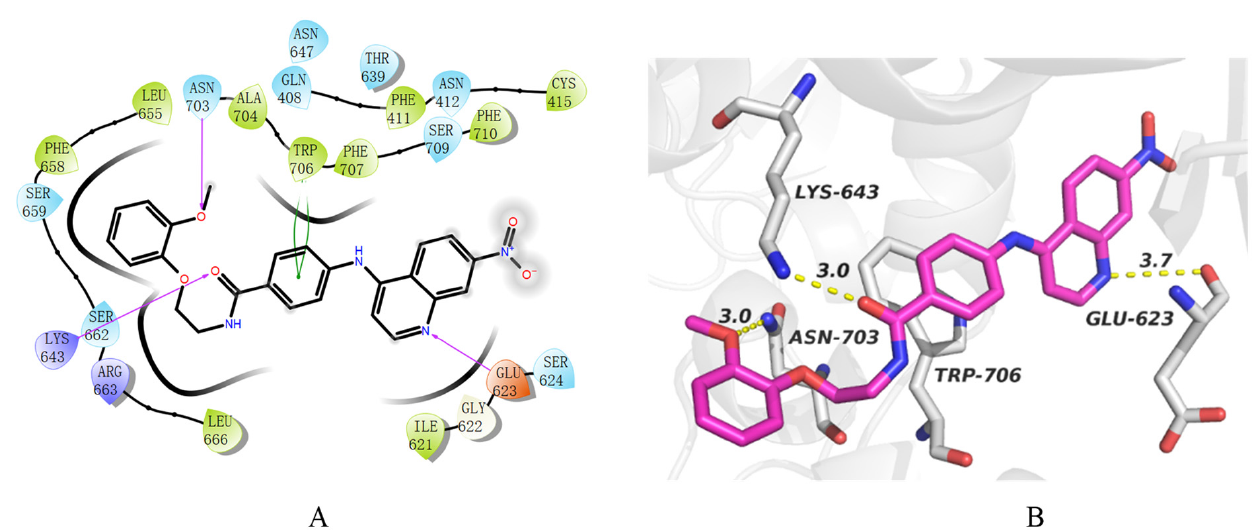
Figure 7. Docking model of G23 in the active site of RNA polymerase (PDB ID: 3CM8). ( A ) The two-dimensional (2D) diagrams of the interactions between G23 and 3CM8. The hydrogen-bond interactions with residues were represented by a purple dashed arrow directed towards the electron donor. The Pi-Pi stacking interactions with residues were represented by the green line segment. ( B ) The three-dimensional (3D) diagrams of the interactions between G23 and 3CM8. The hydrogen- bond interactions with residues were represented by a yellow dashed line.